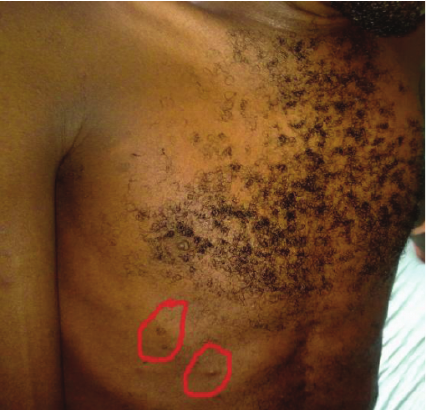
Figure 1: Multiple cutaneous neurofibroma and caf´e-au-lait spots (circled in red).